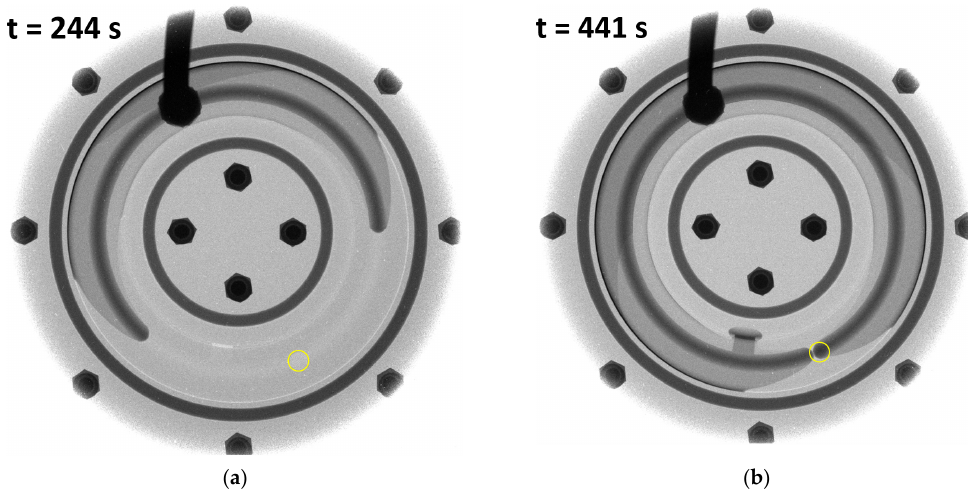
Figure 15. NR images of the filling process for the “Bottom” case. ( a ) NR image at half time of the filling process; ( b ) NR image at touching time of the filling process.